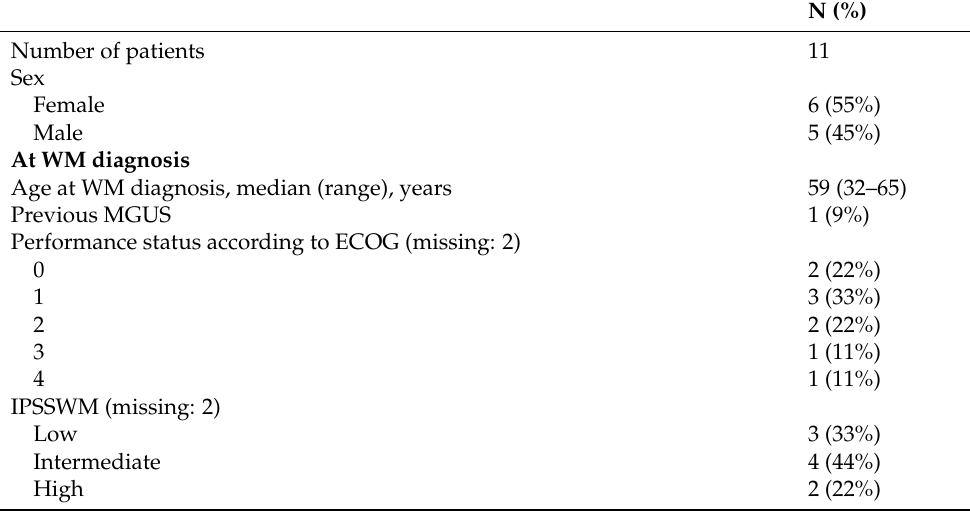
Patients’ characteristics (auto-HCT—autologous hematopoietic cell